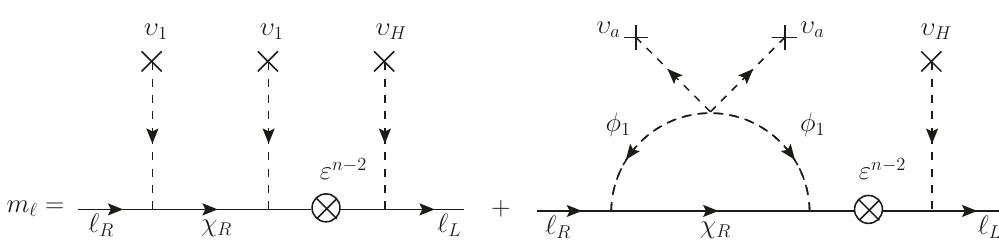
Figure 1 . Froggatt Nielsen (left) and Radiative (right) lepton mass.